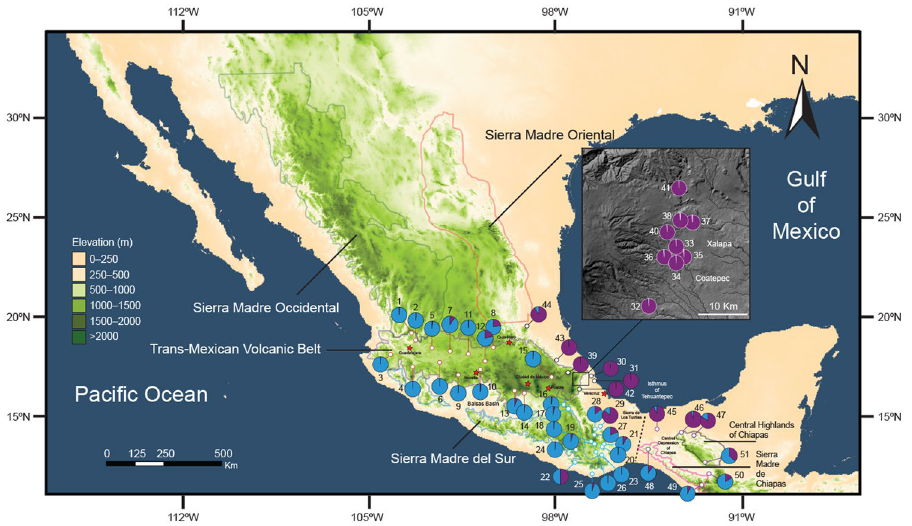
Figure 1. Relief map showing collection sites and assignment probabilities of individuals to populations of the Psittacanthus calyculatus / P . schiedeanus complex in Mexico. In the inset are the collection sites located in central Veracruz. Numbers refer to collection sites according to Table S1. Average assigning probabilities of individuals to putative populations at K = 2 according to STRUCTURE analysis (see Results). Pie colour coding is the same as in Fig. 2. The studied populations are located in the map with specific colours corresponding to the genetic groups: CALY = P . calyculatus (blue), SCHI = P . schiedeanus (purple). Stars represent main cities along the Trans-Mexican Volcanic Belt. The Mexican mountain systems are highlighted by contour lines corresponding to Sierra Madre Occidental (dark green), Sierra Madre Oriental (orange), Trans-Mexican Volcanic Belt (violet), Sierra Madre del Sur (light blue), Sierra Madre de Chiapas (pink), and Central Highlands of Chiapas (black). This map was generated using the ‘raster’ package in R (https://CRAN.R-project.org/package = raster) and the Global 30 arc-second elevation (GTOPO30) model at a 30-arc seconds spatial resolution (c. 1 km) developed with data through a collaborative effort led by the U.S. Geological Survey’s (USGS) Center for Earth Resources Observation and Science (EROS) Center (https://lta.cr.usgs.gov/GTOPO30). The map in the inset is based on digital elevation model (DEM) available from the Instituto Nacional de Estadística y Geografía (INEGI;